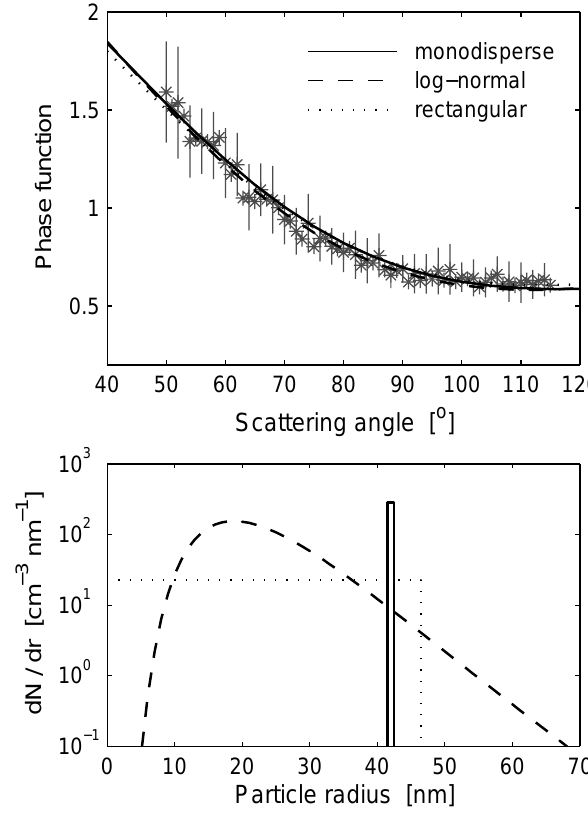
Fig. 4. An example of the ambiguity of photometric NLC measure- ments. Upper panel, points: Phase function of an NLC measured during the DROPPS-2 rocket flight at wavelength 222nm (Gum- bel et al., 2001). Lines: Calculated phase functions that all fit the measurement and that correspond to the three different NLC parti- cle populations in the lower panel (Gumbel and Witt, 2001). Lower panel: Particle populations representing a monodisperse distribu- tion ( r =42nm), a rectangular distribution ( r max =46nm) and a log- normal distribution ( σ =1.4, r mod